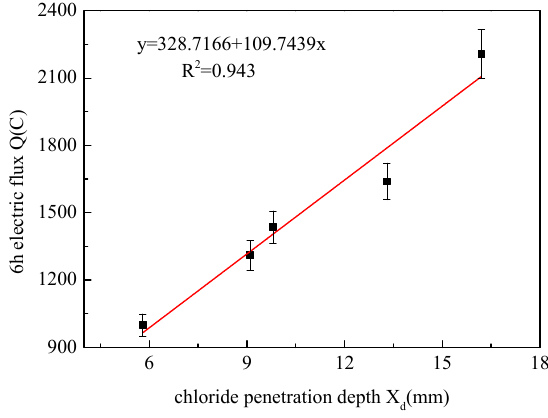
Figure 6. Correlation between chloride penetration depth and 6 h electric flux.